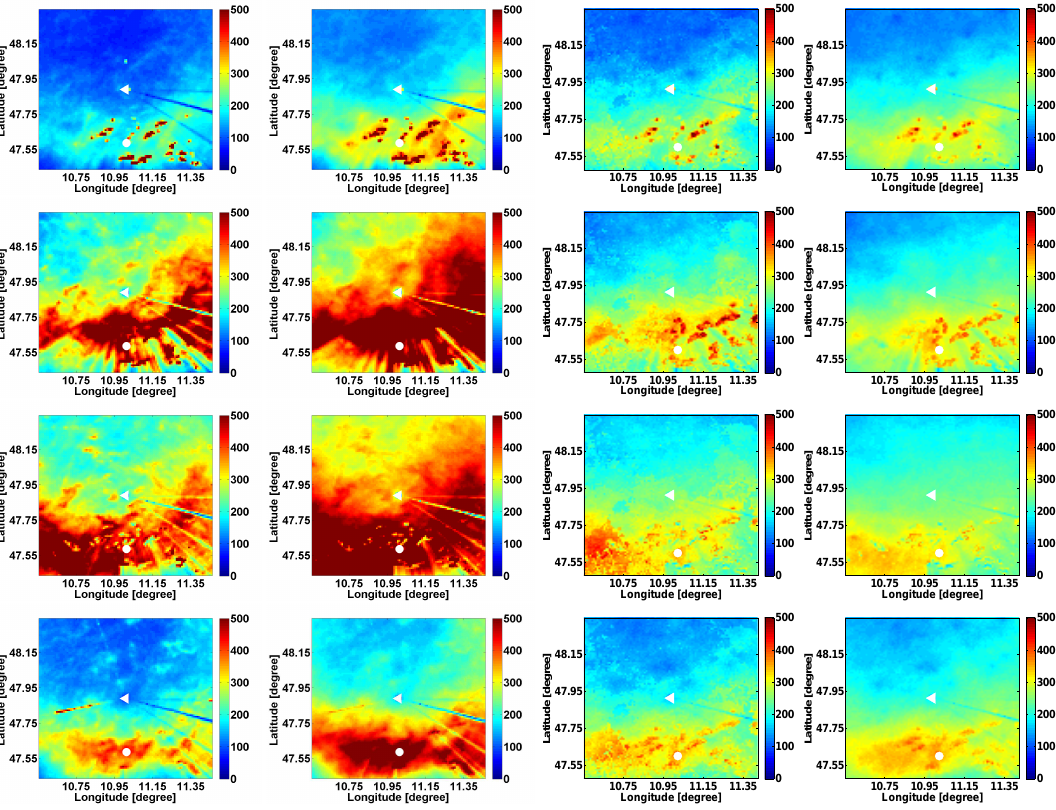
Fig. 11: Accumulated rainfall for summer [mm] obtained by radar (standard Z/R relationship), RADOLAN-correction method, Maximum Theta , and Multiple Theta approach (from left to right) for the years 2005, 2006, 2007, and 2008 (from top to bottom).